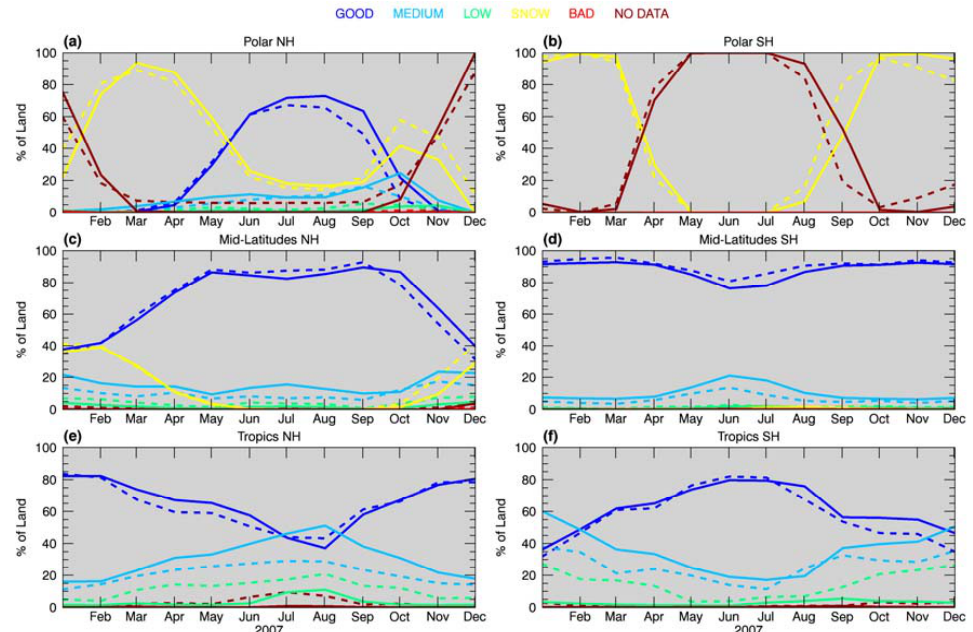
Figure 2. Temporal evolution of the percentage of each flag in 2007. The dashed lines represent C5 and the full lines the C6: ( a ) For Polar regions of the Northern Hemisphere; ( b ) For Polar regions of the Southern Hemisphere; ( c ) For Mid-Latitudes of the Northern Hemisphere; ( d ) For Mid-Latitudes of the Southern Hemisphere; ( e ) For the Tropics of the Northern Hemisphere; ( f ) For the Tropics of the Southern Hemisphere. Colors are similar to those of Figure 1.